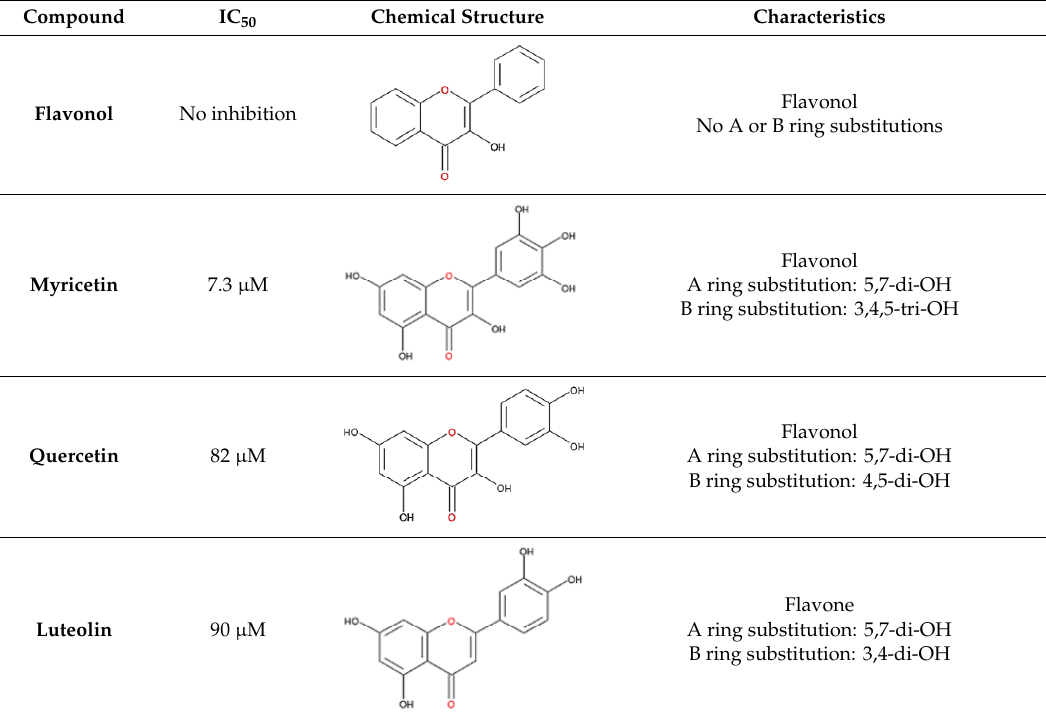
50 to ODC. 50 to ODC.